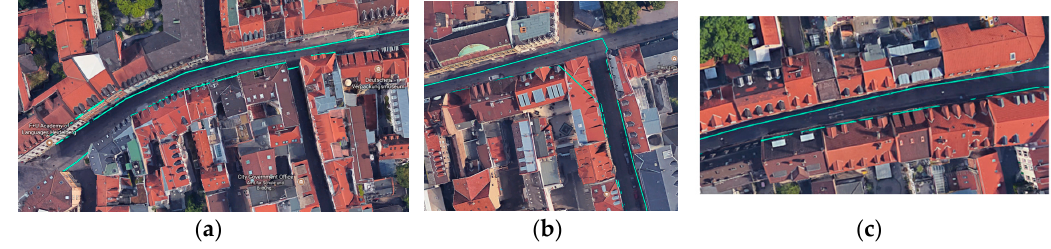
Figure 11. Results of visual inspection of sidewalk network with Google Maps (after applying the enhancement stage): ( a – c) the same areas in Figure 10b–d, respectively. Table 1. Result of extrinsic quality analysis. Table 1. Result of extrinsic quality